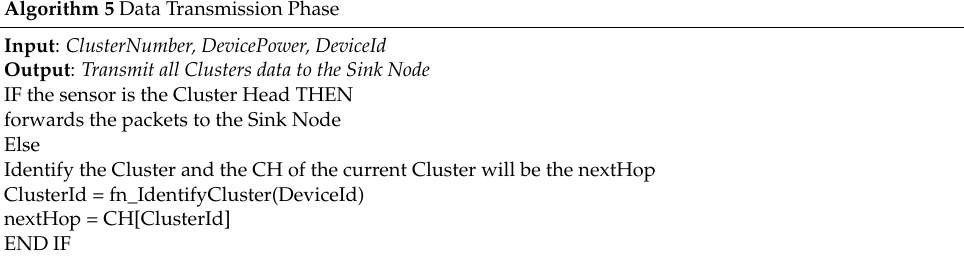
Algorithm 5 Data Transmission